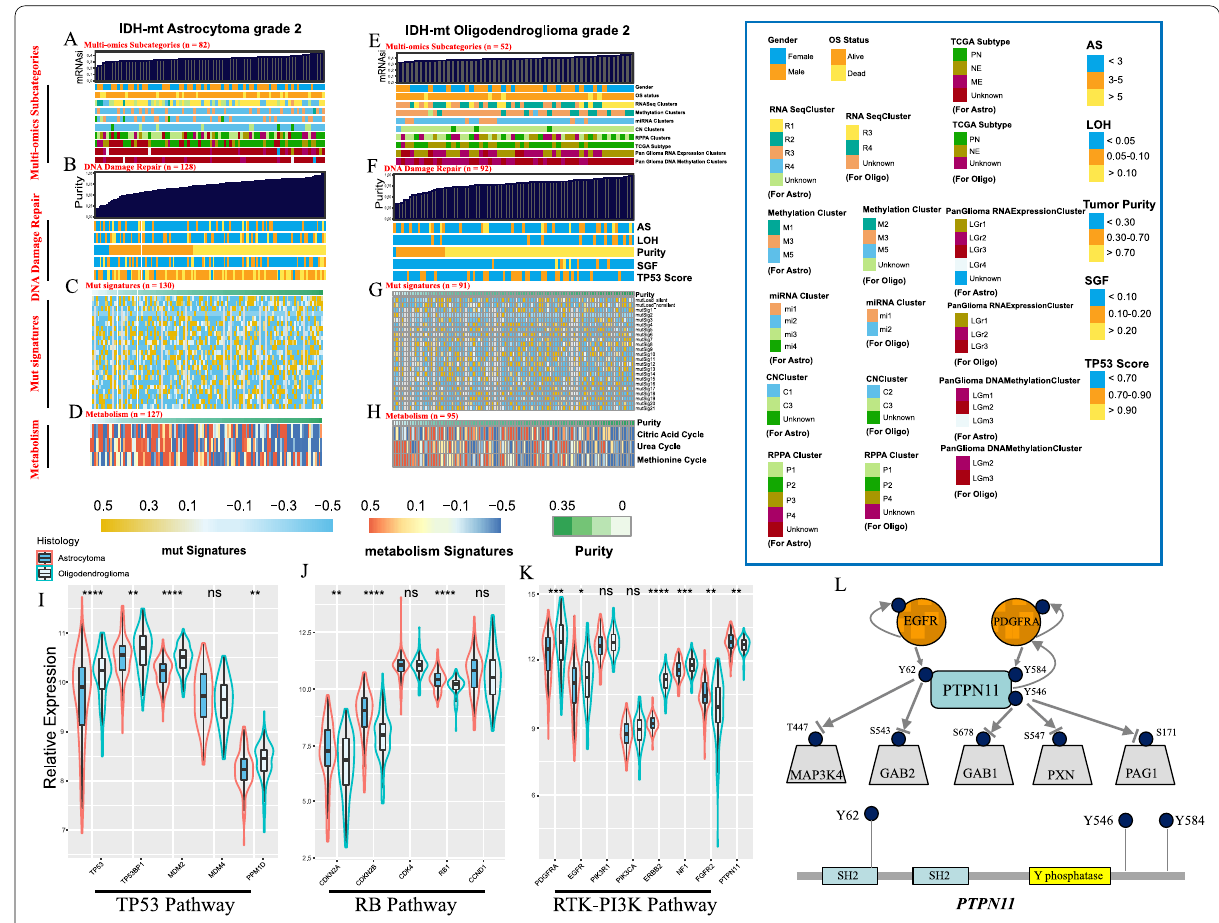
Fig. 4 Landscape of multiomics characteristics and DDR signatures in association with the two entities. A, E Clinical and multiomics subcategories in astrocytoma ( A ) and oligodendroglioma ( E ) with increased mRNAsi. B , F DDR signatures in astrocytoma ( B ) and oligodendroglioma ( F ) with increased tumor purity (Astrocytoma vs. oligodendroglioma in SGF: Wilcoxon P < 0.001, in TP53: Wilcoxon P < 0.001). C, G Mutation signatures of DDR in astrocytoma ( C ) and oligodendroglioma ( G ) with increased tumor purity. D , H Metabolic activities in astrocytoma ( D ) and oligodendroglioma ( H ) with increased tumor purity. I Relative expression of genes in the TP53 pathway in tumors. J . Relative expression of genes in the RB pathway in tumors. K Relative expression of genes in the RTK-PI3K pathway in tumors (Wilcoxon test, *P < 0.05; **P < 0.01; ***P < 0.001; ****P < 0.0001; ns, not significant). L Schematic showing dual regulation of PTPN11 by EGFR and PDGFRA and their downstream substrates. mRNAsi mRNA-expression-based stemness